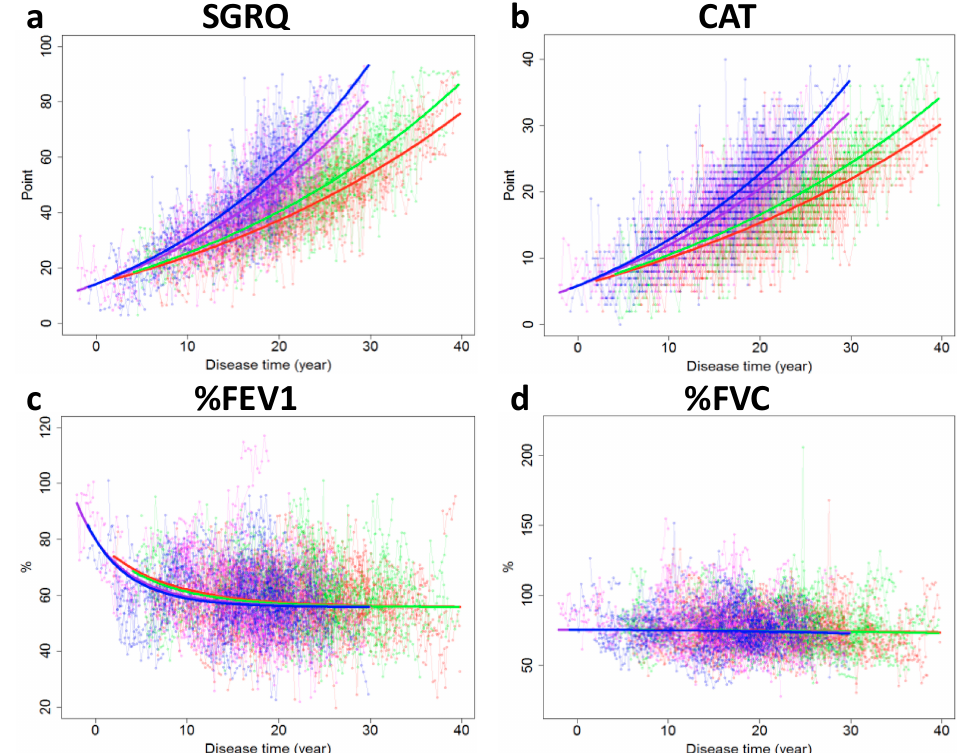
Figure 2. Restoration of fragmented changes in SGRQ score ( a ), CAT score ( b ), %FEV1 ( c ), and %FVC ( d ) by SReFT for long-term progression of COPD considering covariates of the patients. Blue: current smoker with previous exacerbation, Purple: current smoker without previous exacerbation, Green: ex-smoker with previous exacerbation, Red: ex-smoker without previous exacerbation. SGRQ: St. George’s Respiratory Questionnaire, CAT: Chronic obstructive pulmonary disease assessment test, %FEV1: Percentage of predicted forced expiratory volume in 1 second, %FVC: Percentage of predicted forced vital capacity, SReFT: Statistical Restoration of Fragmented Time-course, COPD: Chronic obstructive pulmonary disease. Table 3. Estimated parameters for the progression of COPD by SReFT.